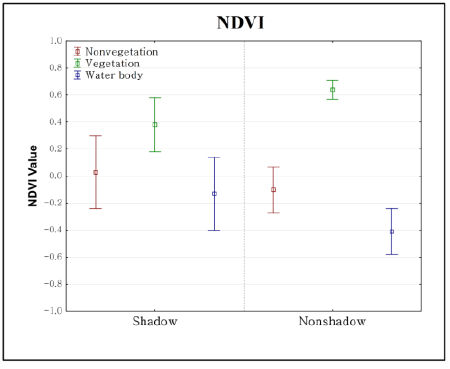
Figure 3. The vegetation index (NDVI) in shadow and non- shadow area; Note: Center squares indicate mean, and the whisker one standard